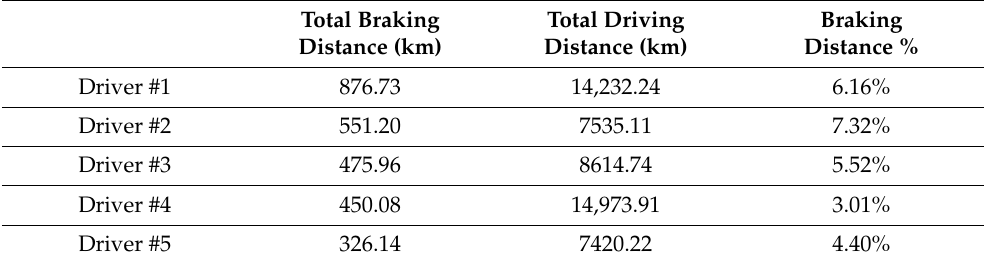
Table 4. Braking distance vs. driving distance comparison among